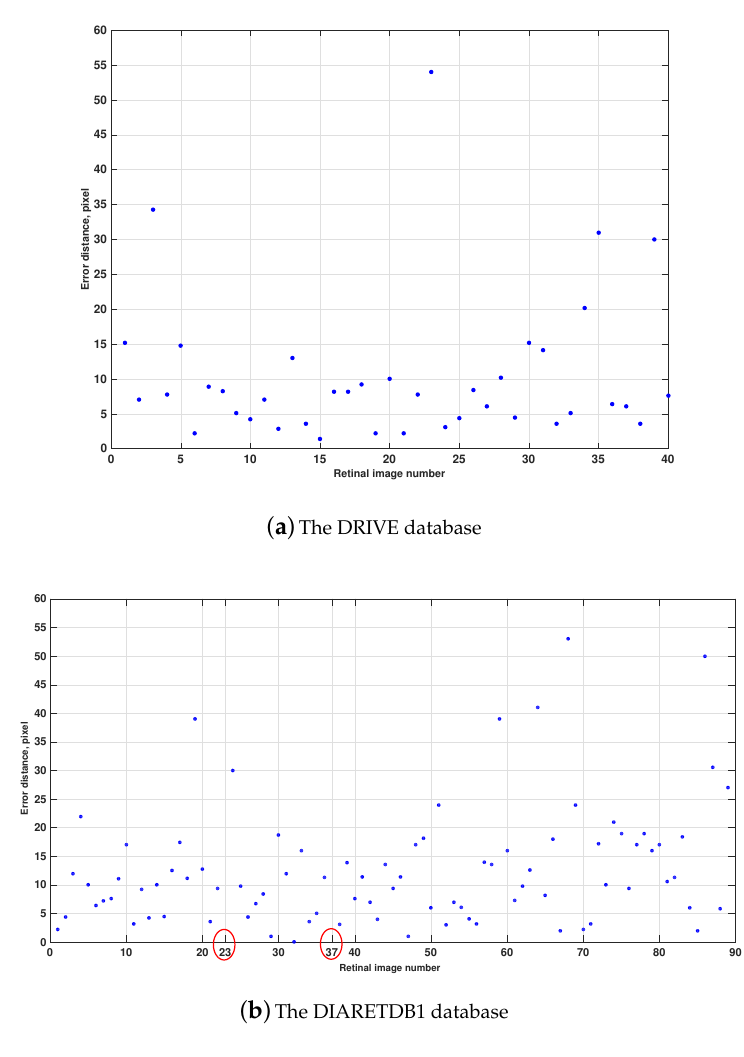
Figure 5. Error distances of OD detection for all databases. The numbers circled in red indicate images in ( b ) that failed to detect ODs.